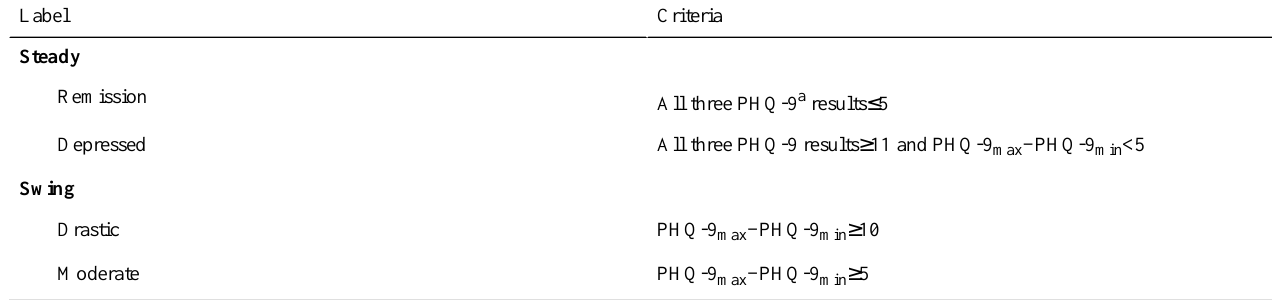
Table 1. Data labels and criteria.